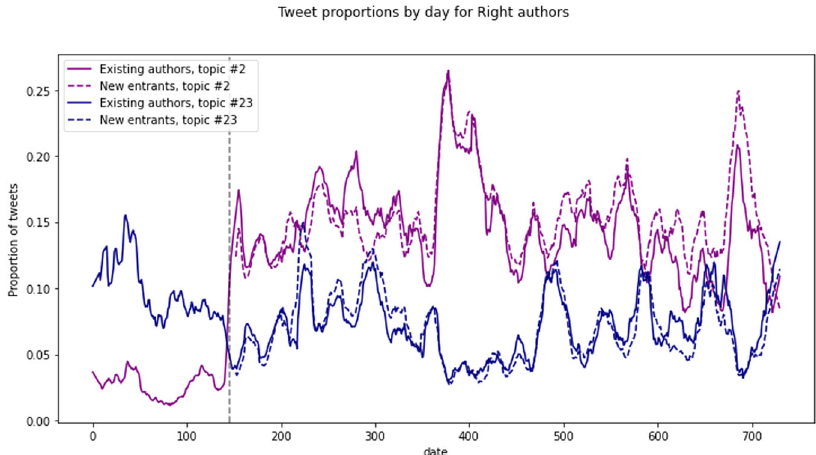
Fig. 6 Proportion of Right tweets with maximum loading on two selected topics, distinguishing authors who posted at least once before Floyd ’ s murder and newcomers. Topic #2 is the “ Antifa terrorist ” framing, #23 is a pro-police topic. Timeseries for each topic smoothed using a 15-day linear Savitzky-Golay fi